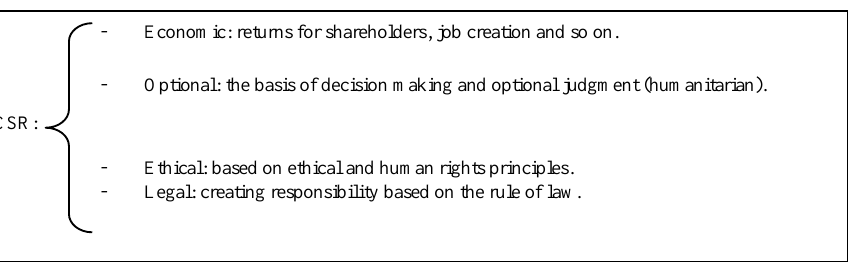
Conceptual model of corporate social responsibility evaluation based on social value